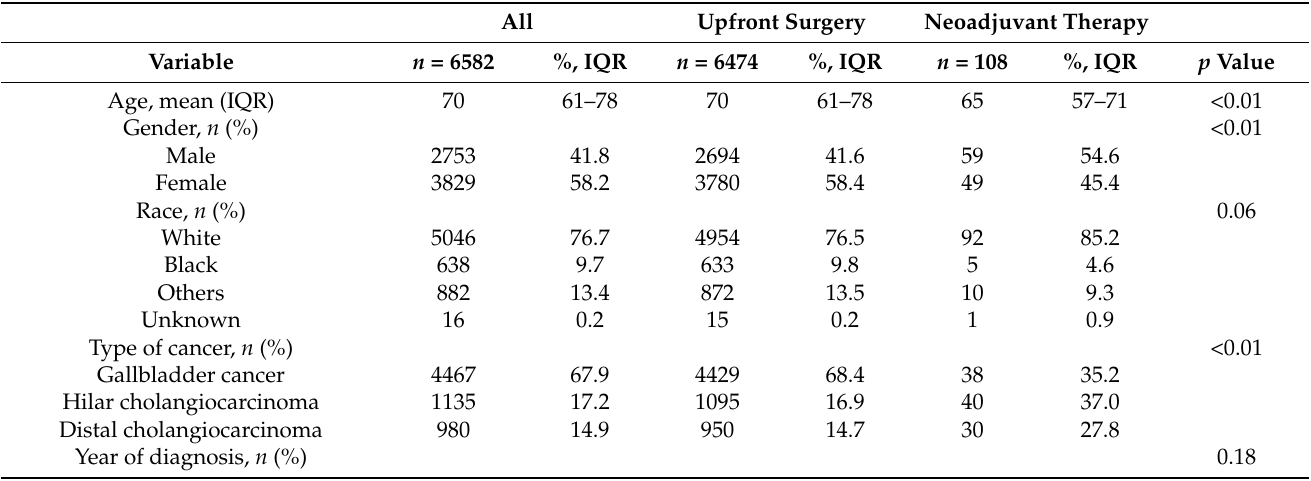
Figure 1. Trends in the number of patients with extrahepatic biliary tract cancer in the SEER registry. Table 1. Patient characteristics by use of neoadjuvant